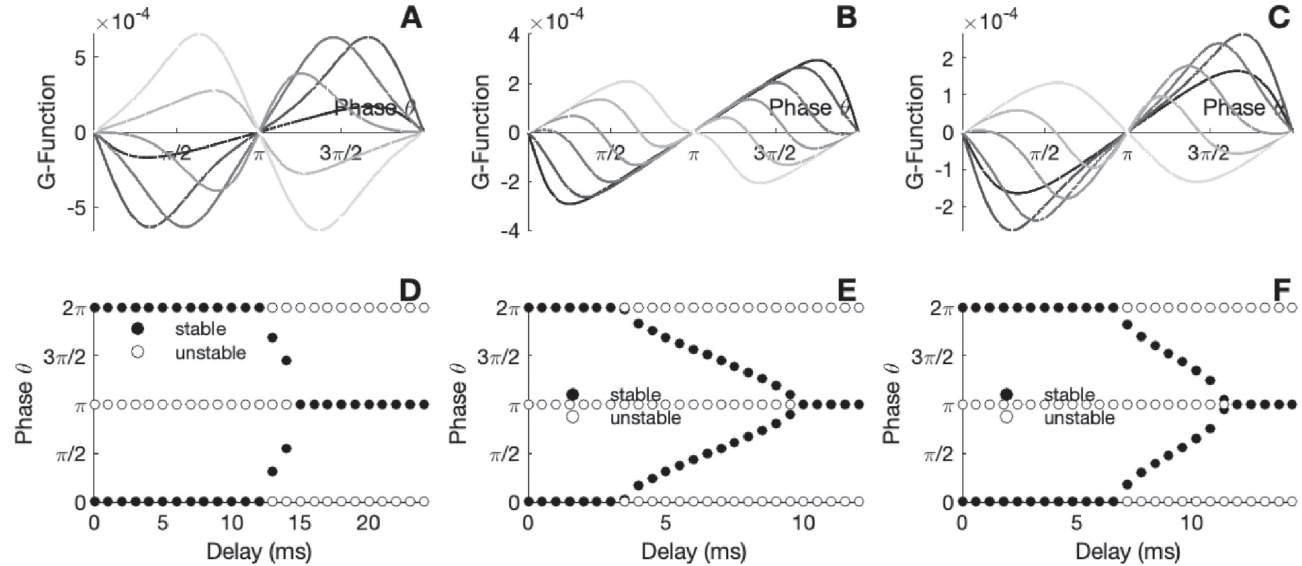
Fig 6. Locking modes of interacting circuits for different ISI densities. A-C) The G -function for different parameter values of the delay. D-E) Zeros of the G - function for different parameter values of the delays. The circles are filled for stable fixed point and empty for the unstable points. Parameters: A-D) S ( h , r ) = exp ( h ) H ( r − T ref ) ε ( r − T ref )), I ext = 2.5 mV , T ref = 6 ms , τ s = 10 ms , J s = 4 mV . ms , ε = 3 and Δ t = 0.05 ms . B-E) S ( h , r ) = exp( h ) H ( r − T ref ) tanh(exp( h )( r − T ref )), I ext = 2.5 mV , T ref = 5 ms , τ s = 10 ms , J s = 3 mV . ms and Δ t = 0.05 ms . C-F) S ( h , r ) = exp( h ) H ( r − T ref ) tanh(exp( h )( r − T ref )) (1 + ε cos( ωr )), I ext = 2.5 mV , T ref = 10 ms , τ s = 3 ms , τ = 5 ms , J s = 15 mV . ms , ε = 3, ω = 1 and Δ t = 0.05 ms